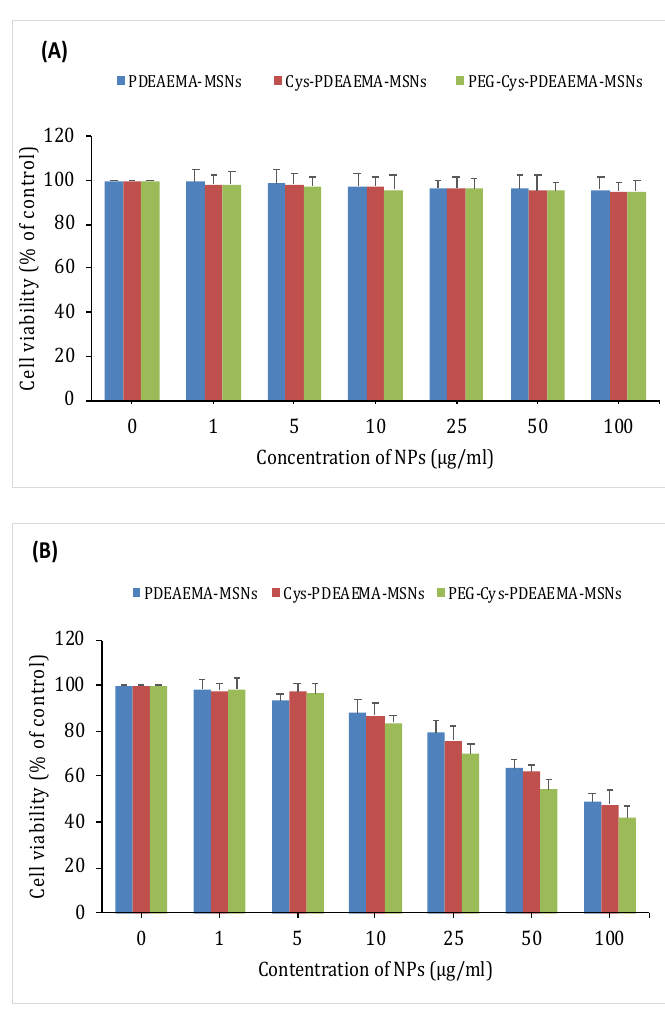
Figure 7. Cell viability of human liver cancer (HepG2) cells after exposure to MSN-PDEAEMA, MSN-PDEAEMA-Cys, and MSN-PDEAEMA-Cys-POEGMEMA. Cells were exposed for 24 h to different concentrations (1–100 µ g/mL) of these materials and cell viability was measured through MTT assay. ( A ) PDEAEMA-MSNs, MSN-PDEAEMA-Cys, and MSN-PDEAEMA-Cys- POEGMEMA without drugs and ( B ) PDEAEMA-MSNs, MSN-PDEAEMA-Cys, and MSN-PDEAEMA-Cys-POEGMEMA with